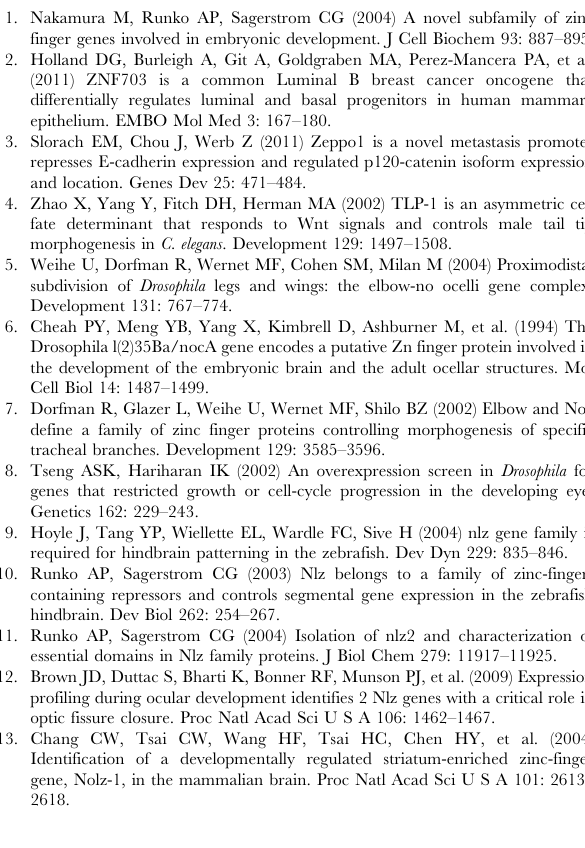
Table S1 LacZ expression in developing UREA-LacZ mouse